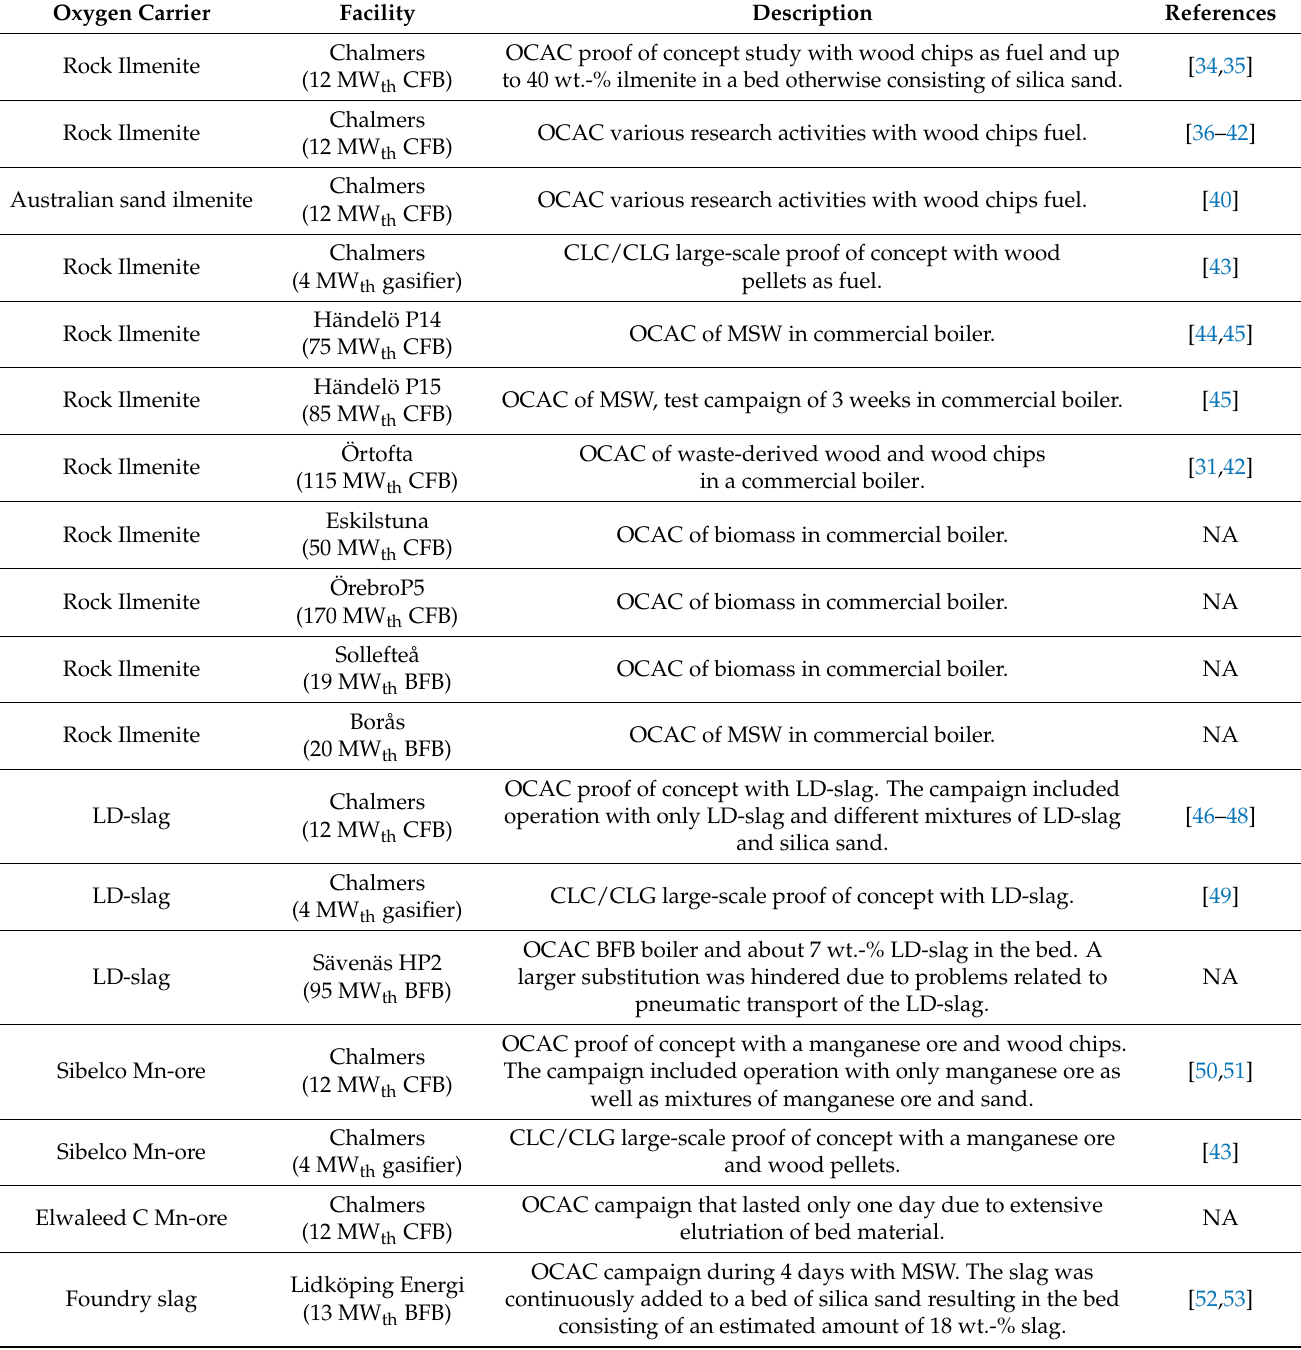
Table 1. Overview of experimental campaigns referred to in this